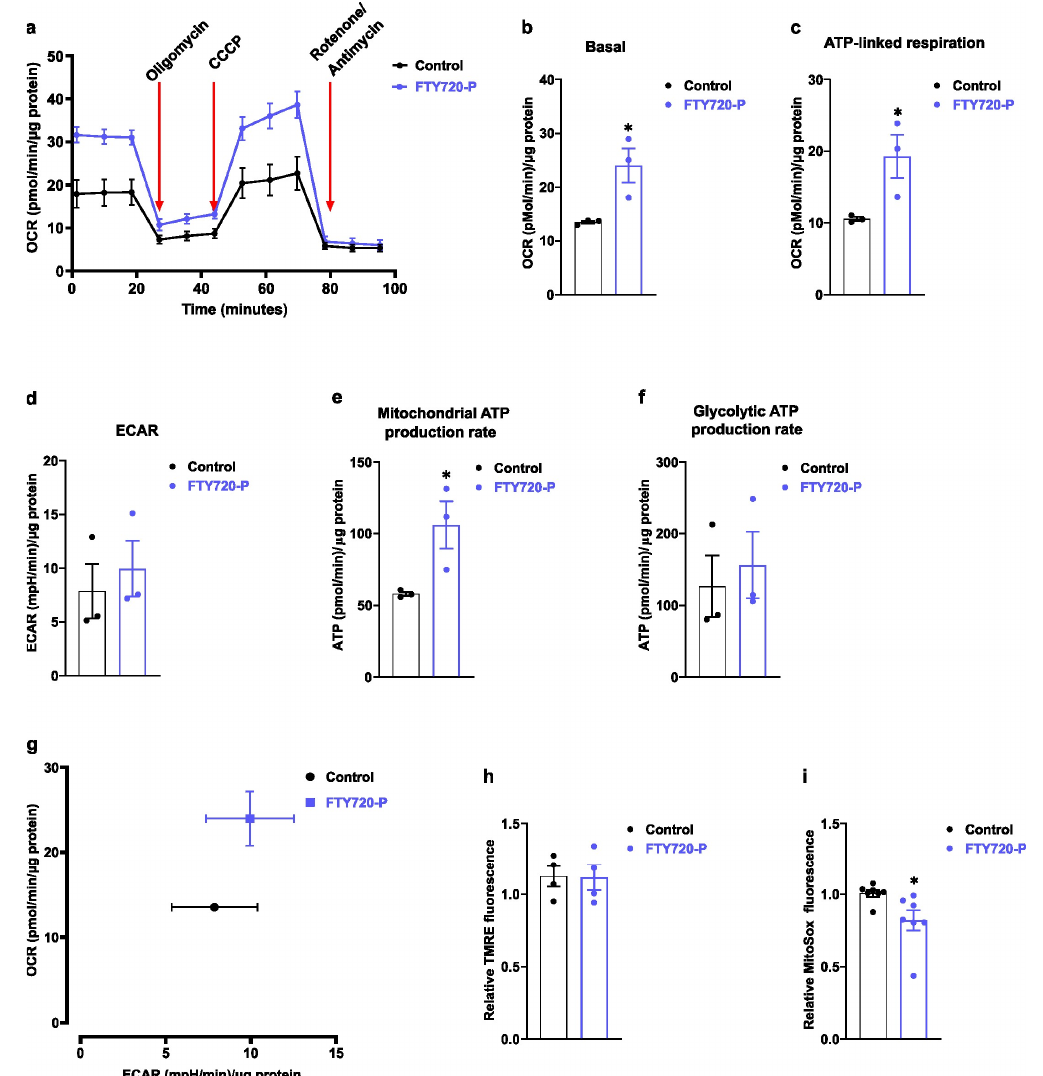
Figure 1. FTY720-P increases mitochondrial function. ( a ) Representative oxygen consumption rate (OCR) profile using Seahorse real-time, live-cell respirometry of AC16 cells treated with FTY720-P for 48 h. Oligomycin (complex V inhibitor) was used to distinguish the ATP-linked mitochondrial respiration and the proton leak across the mitochondrial membrane. CCCP was used to calculate the maximal mitochondrial respiration. Non-mitochondrial OCR was determined by addition of Rotenone and Antimycin A. ( b – d ) AC16 cells were treated with FTY720-P for 48 h and then ( b ) basal, ( c ) ATP-linked respiration, and ( d ) extracellular acidification rate (ECAR) were analyzed using Seahorse respirometry. ( e , f ) Mitochondrial and glycolytic ATP calculated using OCR and ECAR data obtained by Seahorse respirometry. Data were subjected to unpaired t -test. Data are mean ± SEM. * p -value ˂ 0.05 vs. control cells. Graphs represent 3 independent experiments performed in quadruplicate. ( g ) Energy profile of AC16 cells determined as a basal OCR in function of basal ECAR in the indicated conditions. ( h ) Mitochondrial potential was detected using the TMRE potentiometric probe. Cells were incubated with FTY720-P for 48 h and then cells were stained with 100 nM TMRE for 20 min. Data are mean ± SEM. Graphs represent 4 independent experiments performed in triplicate. ( i ) Mitochondrial superoxide was detected using MitoSox probe. Cells were incubated with 2.5 μ M MitoSox for 30 min, then washed and analyzed by flow cytometry. Data were subjected to unpaired t -test. Data are mean ± SEM. * p -value ˂ 0.05 vs. control cells. Graphs represent 7 independent experiments performed in triplicate.